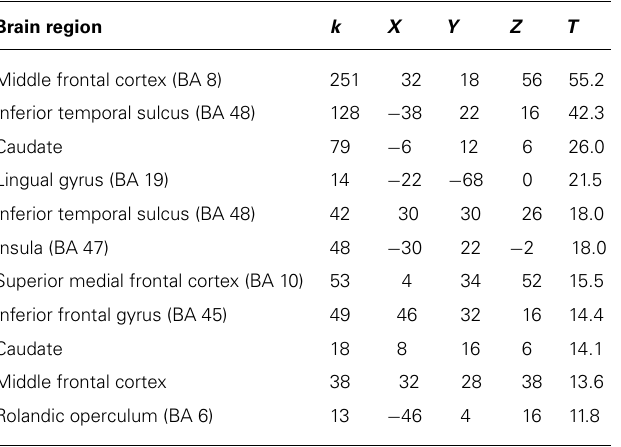
Table 3 | Brain regions and local maxima of clusters, recruited by experts during action observation of successful trials compared to unsuccessful